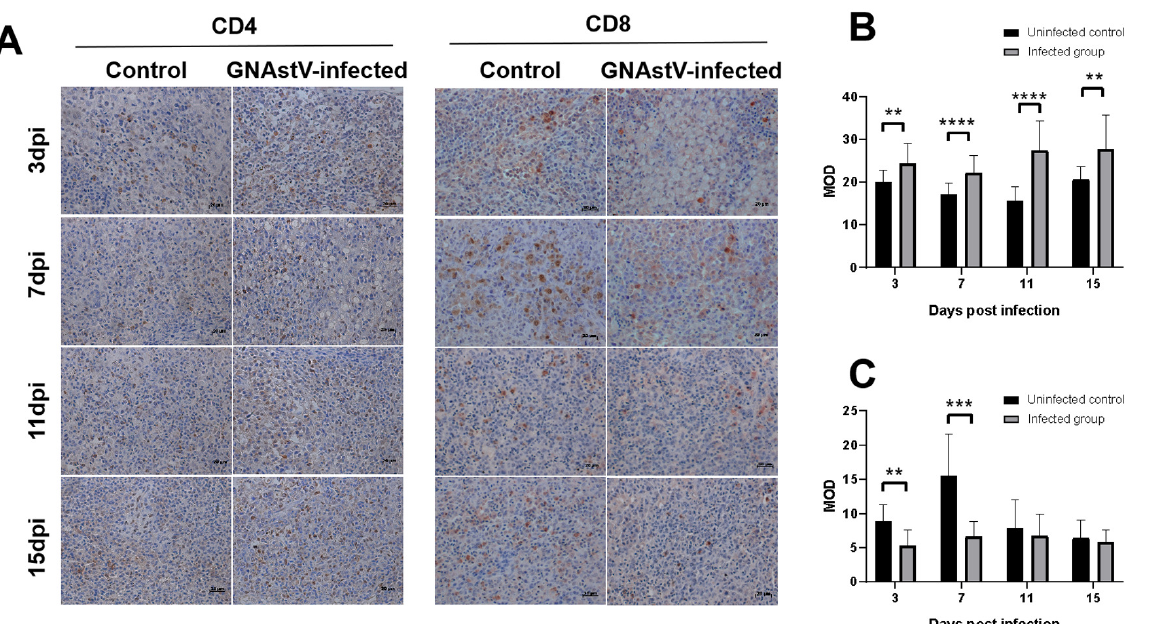
Figure 9. Immunohistochemical examination of the spleen using CD4 and CD8 antibodies. Changes in positive signals of CD4 and CD8 in the spleen at 3, 7, 11, and 15 dpi after infection with GNAstV ( A ). The mean optical density (MOD) of a CD4 positive signal ( B ) and CD8 positive signal ( C ) was calculated by Image-Pro Plus. Scale bar: 20 µ m. Values are expressed as mean ± SD, n = 5. ** p < 0.01; *** p < 0.001; **** p < 0.0001.